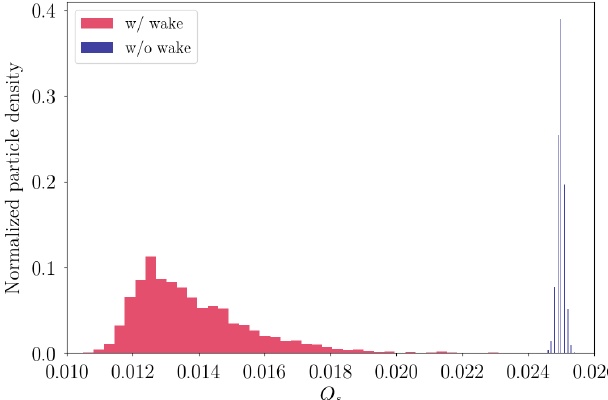
FIG. 9. Incoherent synchrotron tune distribution at nominal intensity, produced by the resistive wall impedance with a coating of 100 nm. The results are obtained with P Y HEATAIL by using the machine parameters of Table I at the lowest machine energy.